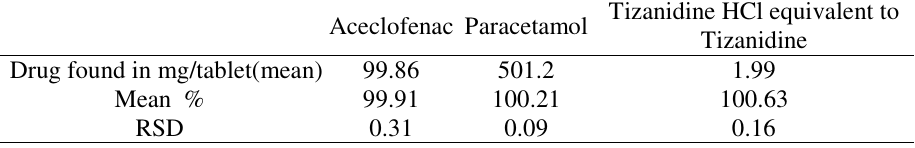
Table 3. Results of assay